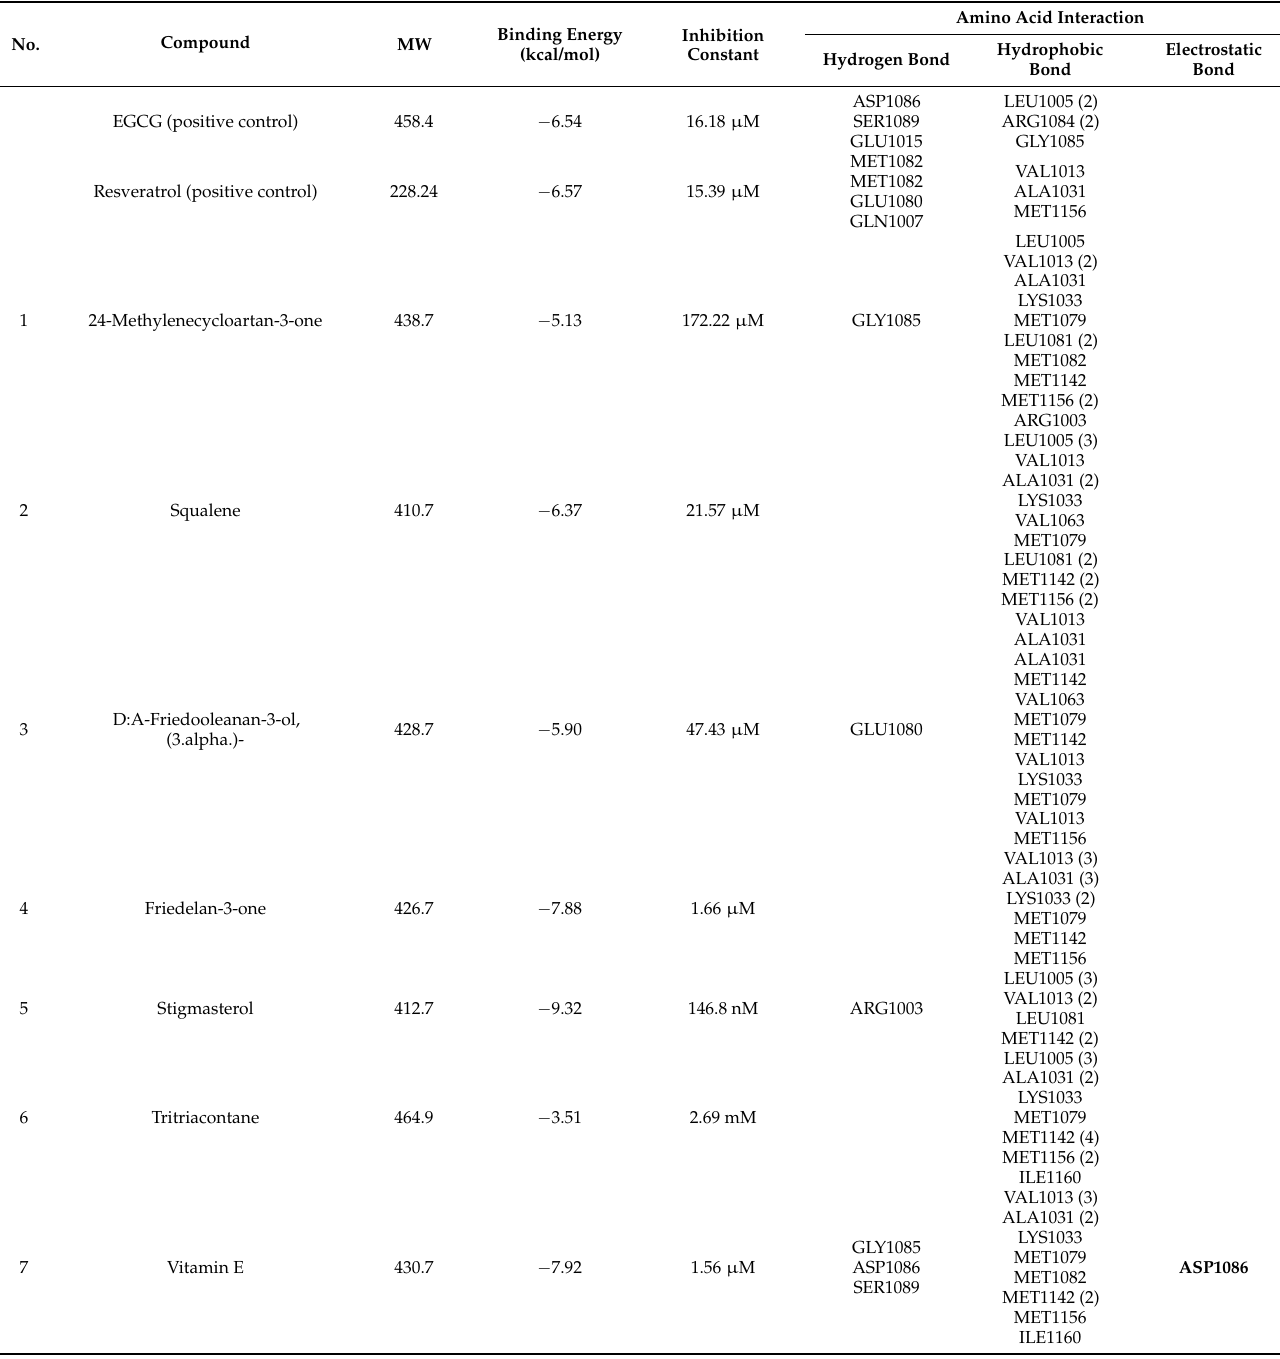
Table 4. Docking results of the compounds with